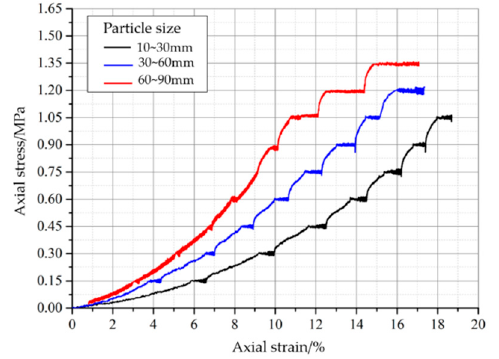
Figure 7. The stress-strain curves of the tested crushed mudstone samples for the entire loading process under the incremental loading.